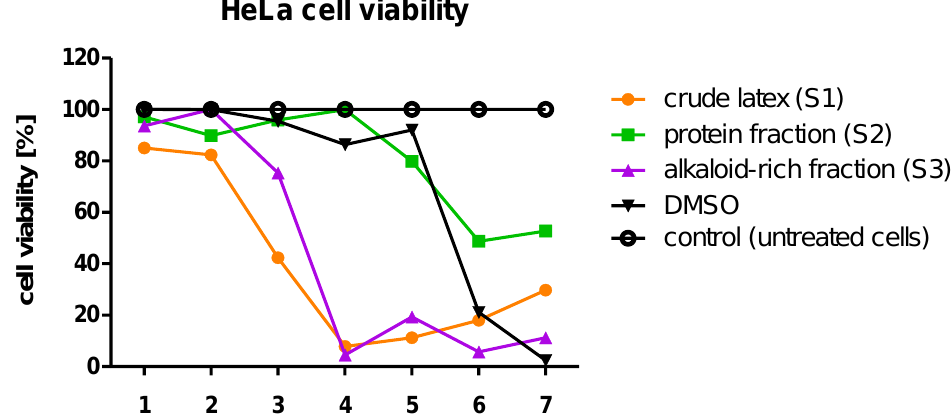
Figure 1. Effect of crude C. majus latex (S1), protein fraction (S2), and alkaloid-rich fraction (S3) on the viability of HeLa cells. Consecutive numbers (1–7) on the x axis correspond to different protein concentrations in the crude latex (S1) and protein fraction (S2) applied on cells: 1 = 4.0 × 10 − 4 mg/mL, 2 = 8.0 × 10 − 4 mg/mL, 3 = 1.6 × 10 − 3 mg/mL, 4 = 8.0 × 10 − 3 mg/mL, 5 = 1.6 × 10 − 2 mg/mL, 6 = 4.0 × 10 − 2 mg/mL, 7 = 8.0 × 10 − 2 mg/mL. In the case of alkaloid fraction (S3), consecutive numbers (1–7) correspond to its different dilutions: 1 = 5 × 10 − 4 , 2 = 10 − 3 , 3 = 2 × 10 − 3 , 4 = 10 − 2 , 5 = 2 × 10 − 2 , 6 = 5 × 10 − 2 , 7 = 10 − 1 . They were obtained using series of dilutions from concentrated samples. Among the tested samples, the strongest cytotoxicity was shown by the crude latex and the alkaloid-rich fraction in the range of 8.0 × 10 − 2 –8.0 × 10 − 3 mg/mL (numbers 4–7). The protein fraction showed the lowest toxicity towards HeLa cells in all analyzed concentrations. All tested samples in the concentration range of 8.0 × 10 − 4 –4.0 × 10 − 4 mg/mL (numbers 1–2) exhibited the lowest